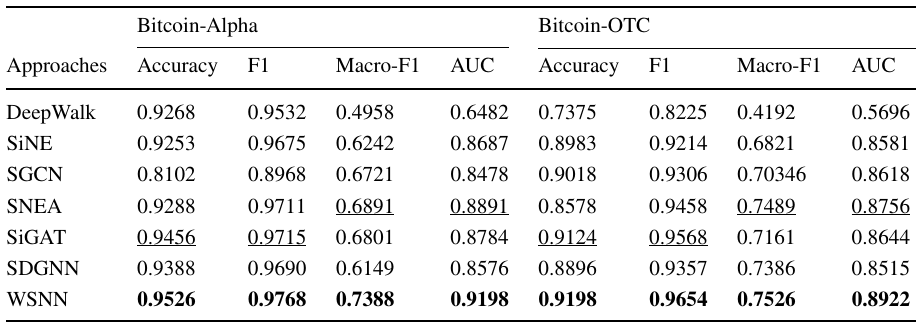
Bold indicates the best experimental effect, and horizontal bar indicates the second best